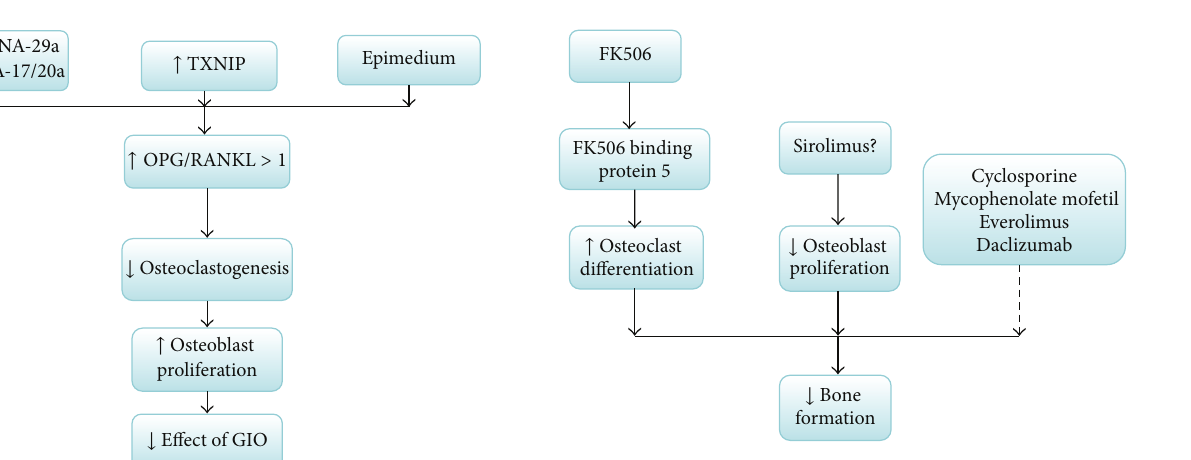
Figure 3: Effect of the nonglucocorticoid immunosuppressant on bone. FK506 binding protein 5 (FKBP5) messenger RNA (mRNA) can promote osteoclast differentiation, involved in glucocorticoid- induced osteoporosis; the function of sirolimus (SRL) on bone should be more discussed. The dashed arrows show that the other nonglucocorticoid immunosuppressants may not influence bone formationandbonemassorarestillbeingevaluatedfortheirskeletal